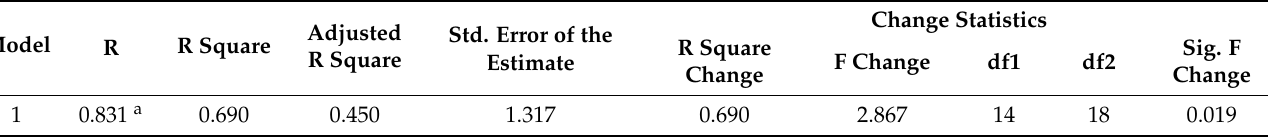
Table 10. Model Summary—Shared charging system b .